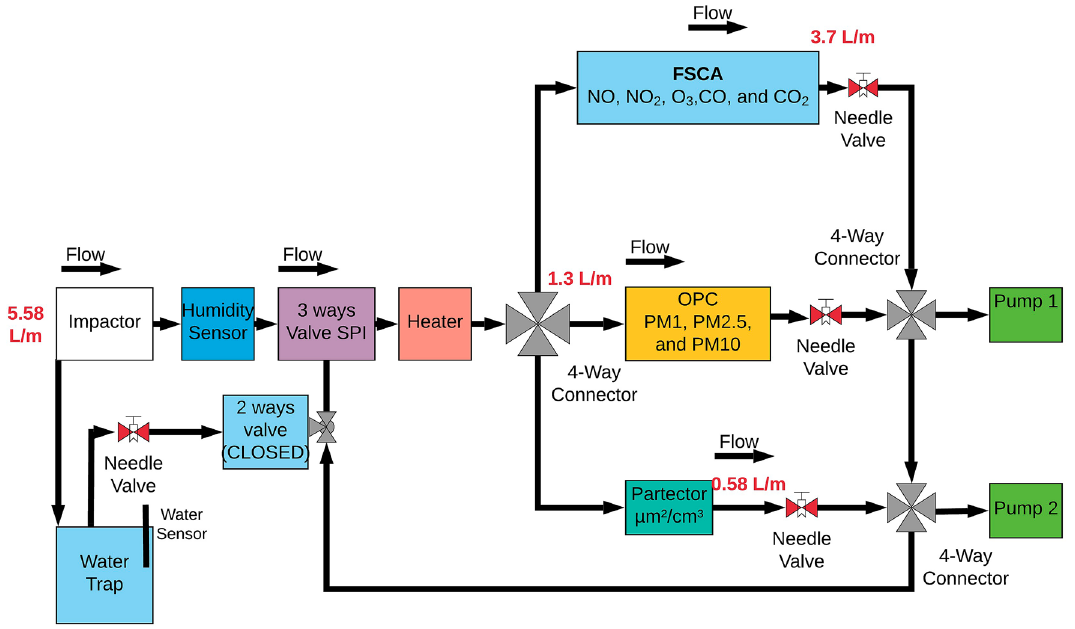
Fig. 2 Schematic of The mobile autonomous air quality sensor box